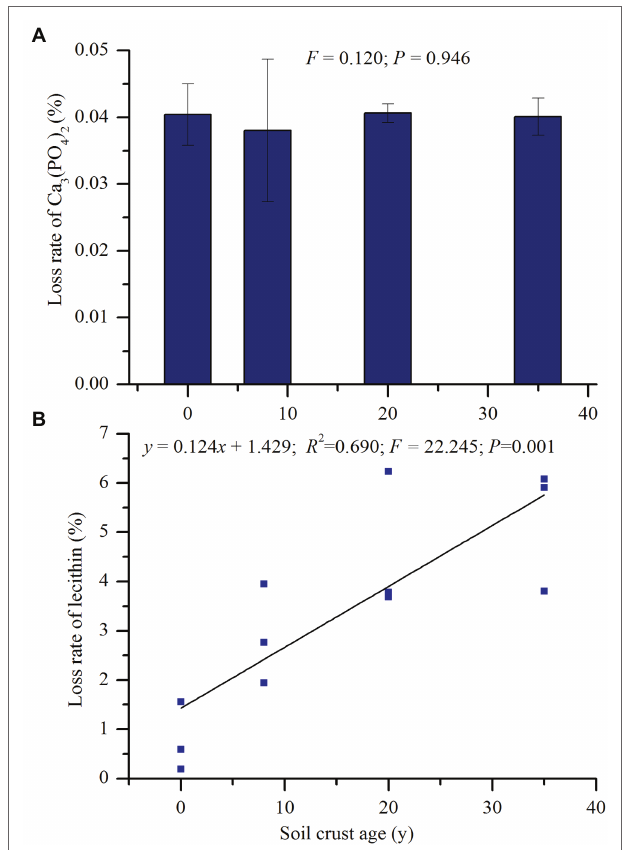
FIGURE 1 | Responses of the potentials of inorganic P (IP) solubilization (A) estimated by the loss rate of phosphorite and organic P (OP) mineralization (B) estimated by the loss rate of lecithin quantitatively added in a microbial medium to biological soil crust (BSC) development.